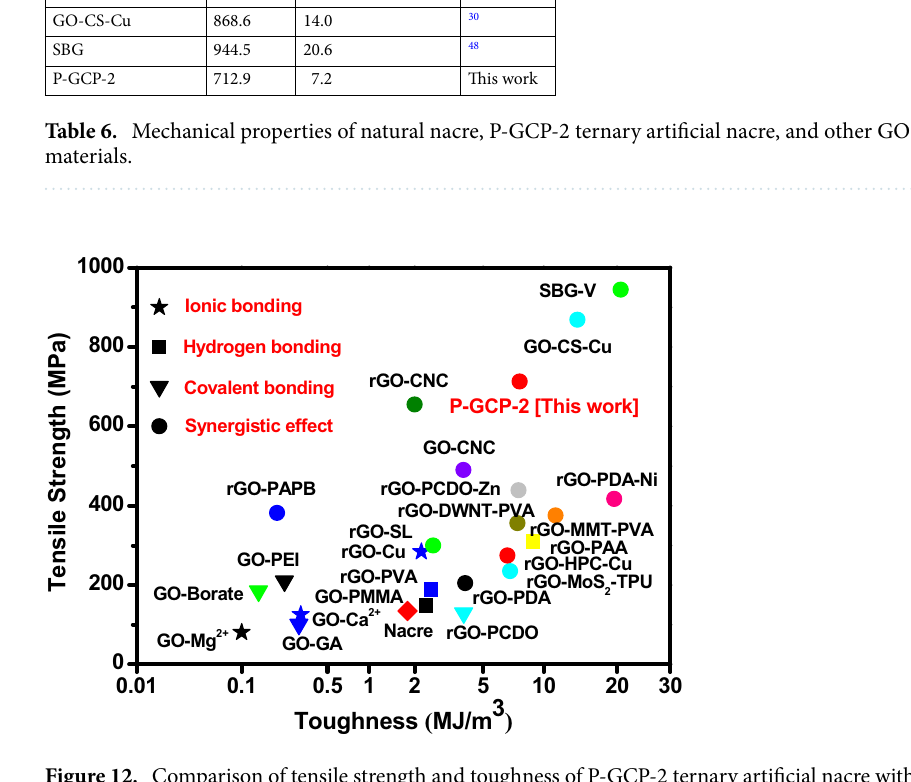
Figure 12. Comparison of tensile strength and toughness of P-GCP-2 ternary artificial nacre with those of other layered